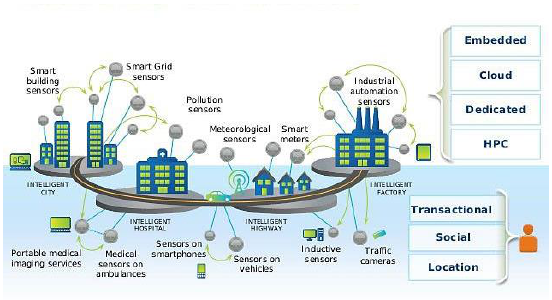
Figure 1. Sensors in smart